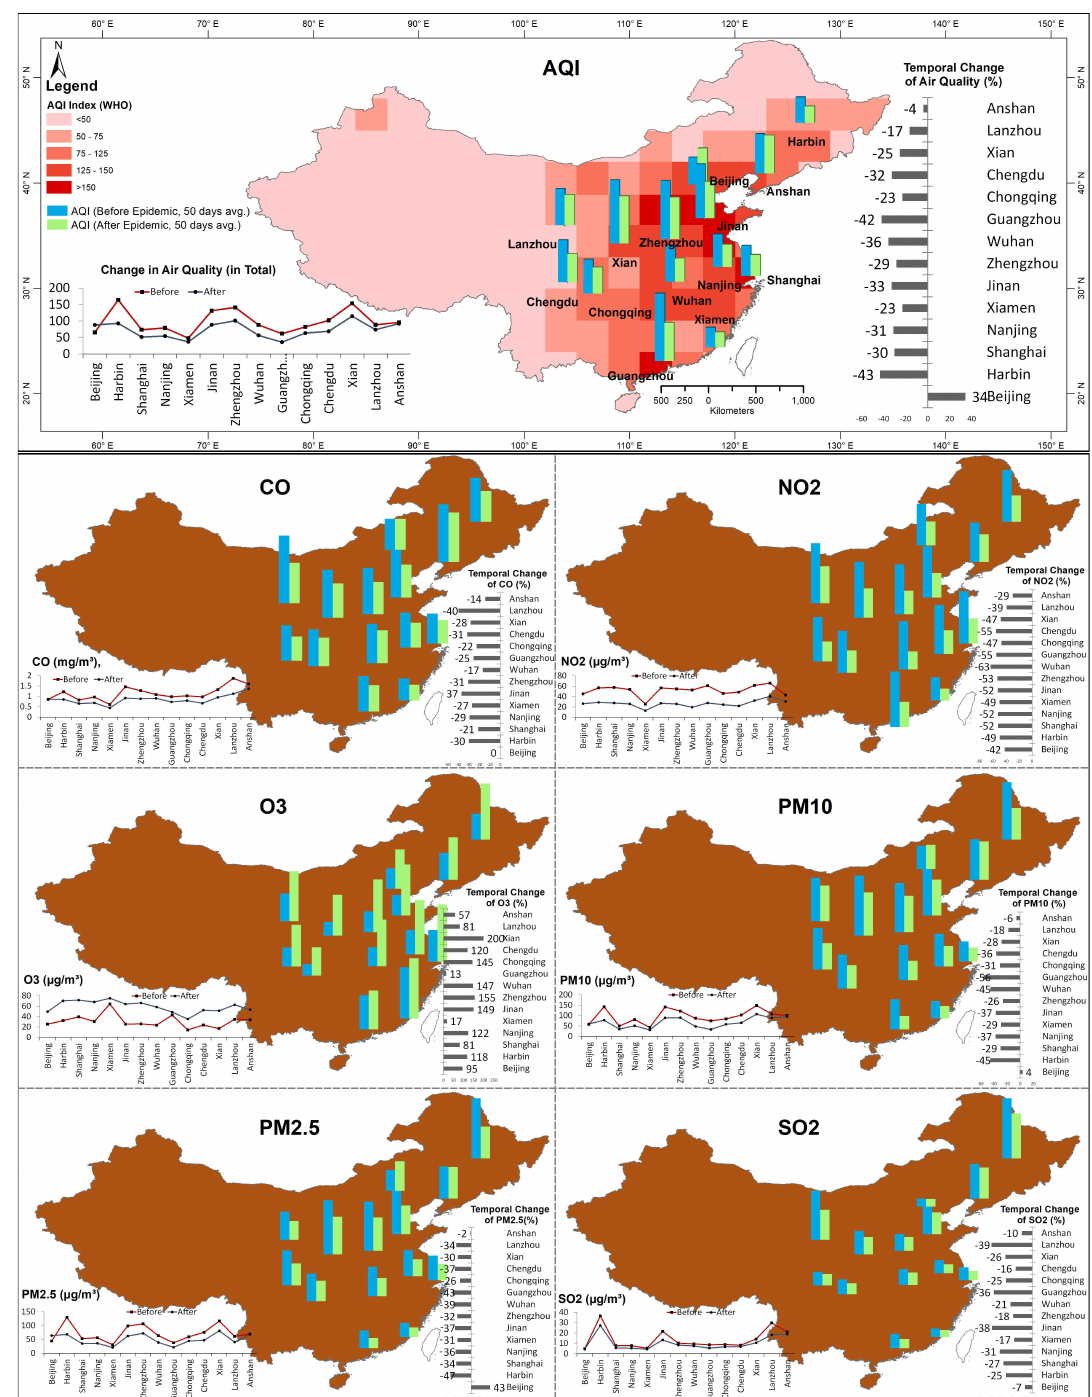
Figure 8. Temporal change in air quality of China before and after lockdown. Total 100-day daily average data, 4 December 2019 to 22 January 2020 (before lockdown) and 23 January to 12 March 2020 (after lockdown). ( a ) Air Quality Index; ( b ) CO; ( c ) NO 2 ; ( d ) O 3 ; ( e ) PM 10 ; ( f ) PM 2.5 ; ( g ) SO 2 . Source: Ministry of Environmental Protection of China (MEPC), China Ministry of Ecology and Environment, 2020 and OMI, Global Modeling and Assimilation Office,